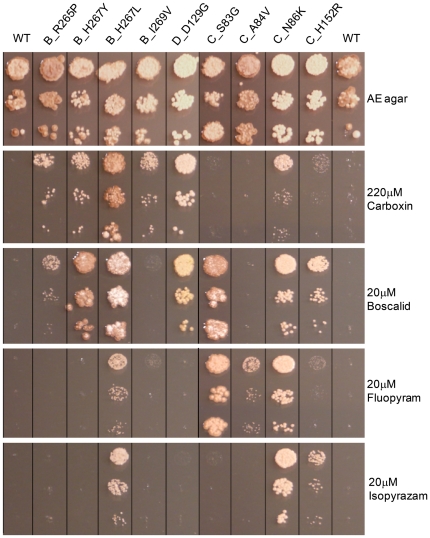
Comparative growth of homologous recombinant strains on various carboxamide amended media.All strains were grown on AE agar supplemented (or not) with the indicated active ingredient (final concentration indicated). Cell suspensions obtained from 4 days old V8 agar plates were serially diluted by 10 fold factor steps in liquid AE and 2 ul were spotted onto the plates. Pictures were taken 10 days post inoculation for carboxamides amended plates and 6 days post inoculation for AE plate. Pictures were taken from same plates and reordered for visualization.